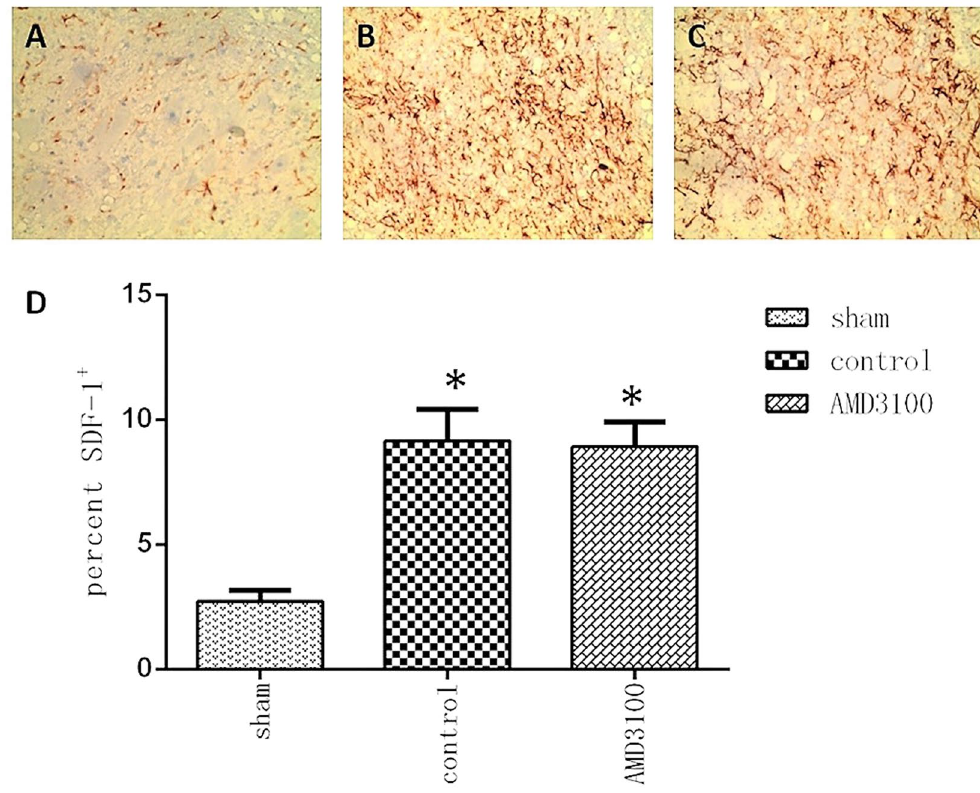
Figure 1. The protein expression of SDF-1 up-regulated in neural stem cells of the lesion site on the 7th day after surgery. ( A ) Representative image of IHC staining of SDF-1 in sham group ( × 400). ( B and C ) Representative images of IHC staining of SDF-1 in untreated and AMD3100 groups ( × 400). The expression of SDF-1 protein increased in the neural stem cells after SCI. ( D ) The expression of SDF-1 was significant higher in untreated and AMD3100 groups than those in sham group. ( * P < 0.05: untreated group vs. sham group, AMD3100 group vs. sham